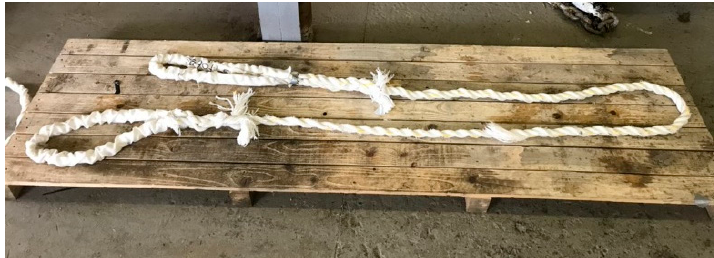
Figure 11. One broken strand near end of eye splice (Test 02 at DMaC), representative of the dominant failure mode.